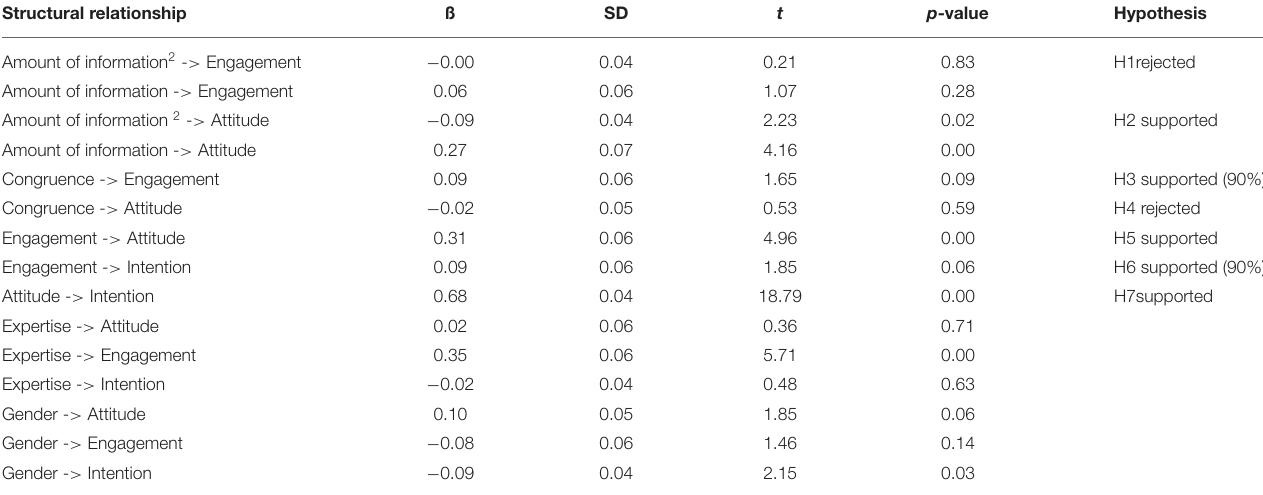
TABLE 4 | Structural